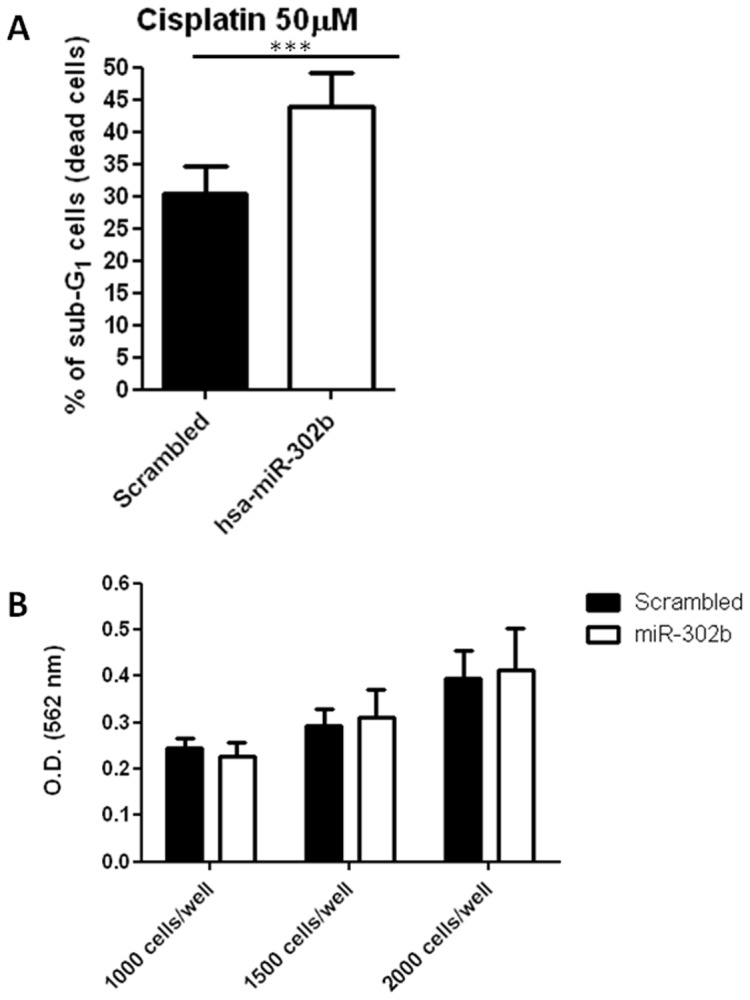
Forced expression of hsa-miR-302b increased cisplatin sensitivity in IGROV-1 cells without affecting cell proliferation.(A) Percent cell death of hsa-miR-302b- and scrambled-transfected cells after cisplatin treatment. IGROV-1 cells were transfected with 50 nmol/l hsa-miR-302b precursor molecule or scrambled control, and 72 h later, exposed to cisplatin (50 µM) for 1 h. Cell viability was assessed 24 h after cisplatin treatment by propidium iodide staining and flow cytometry. Data represent mean ± SEM of 6 independent experiments. ***p<0.0001 by paired t-test. (B) Evaluation of cell proliferation by SRB assay. Transfected cells were seeded in a 96-well plate at a density of 103, 1.5×103, and 2×103 cells/well. Cell growth was assessed by optical density (OD) determination 72 h after transfection. Data represent mean ± SEM of 3 independent experiments.